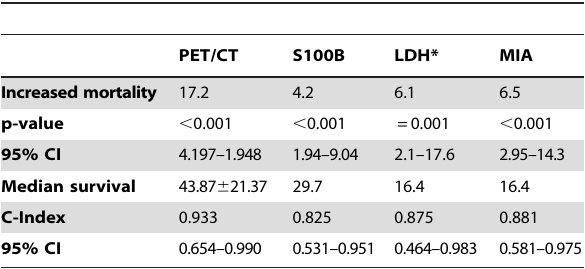
Table 4. Mortality risk (Hazard ratios) in patients positive for PET/CT, S100B, LDH or